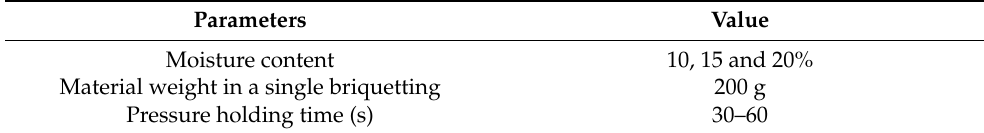
Table 3. Material parameter